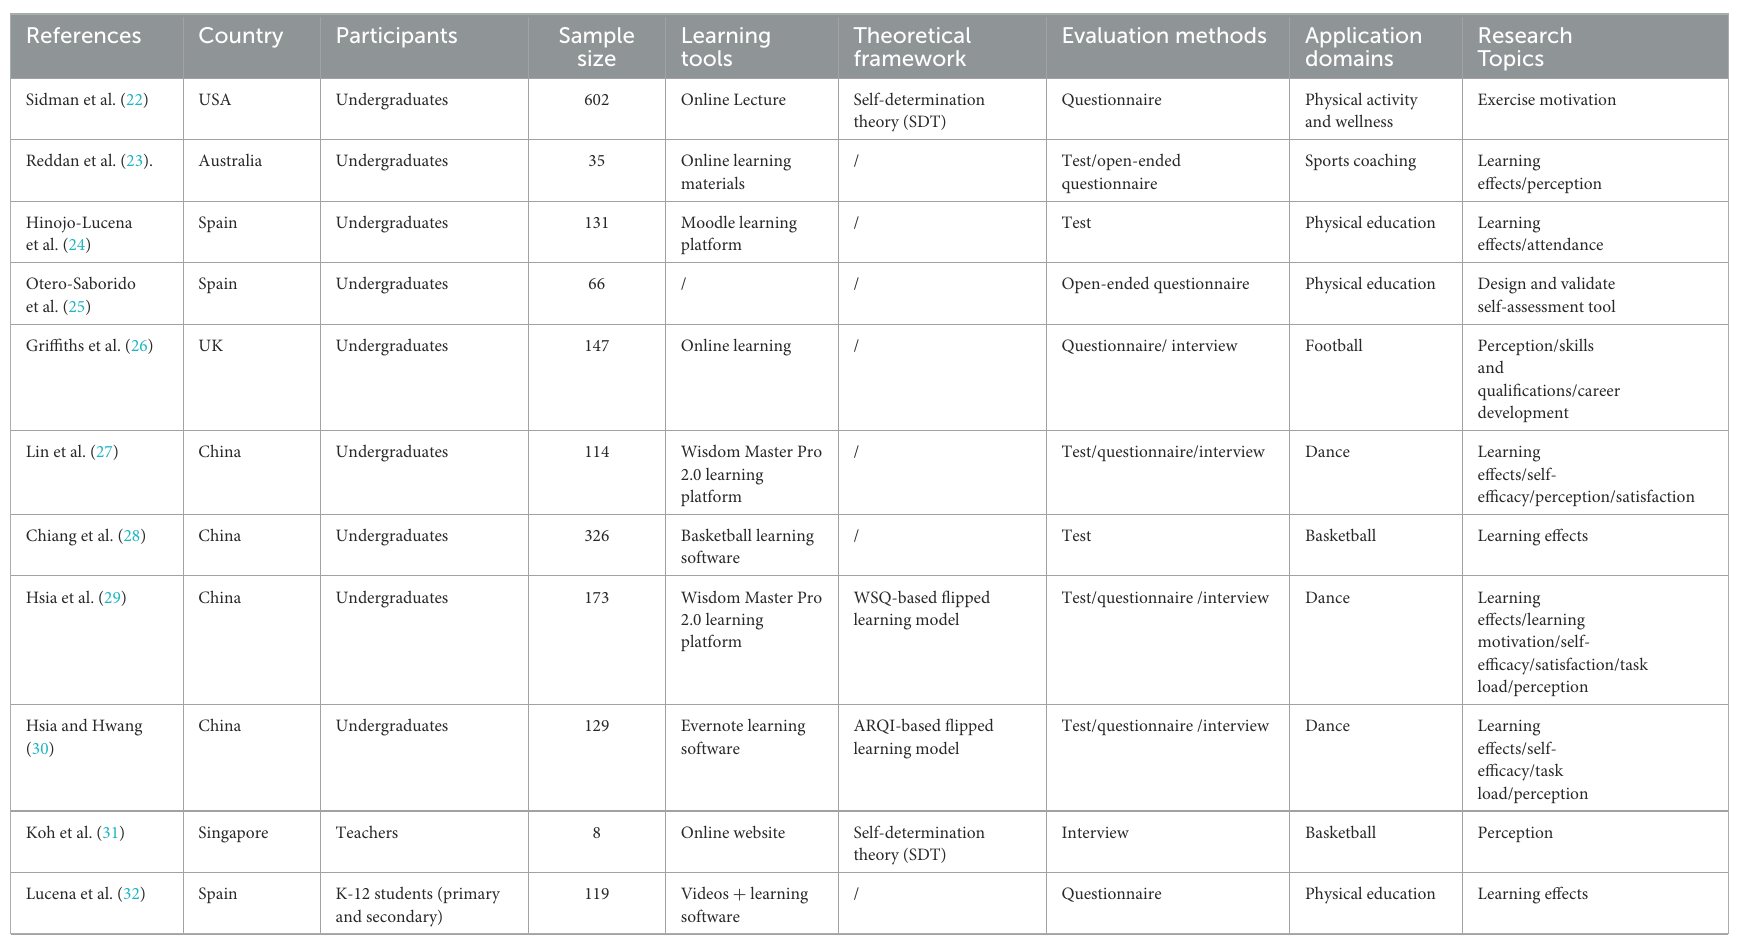
TABLE 2 Characteristics of the studies examined in the preset